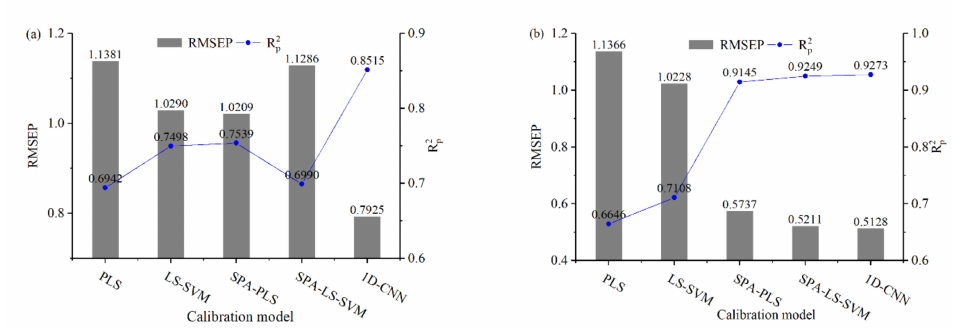
Figure 8. The best prediction accuracy of different calibration models: ( a ) spectrophotometer experi- ment; ( b ) grating spectrograph